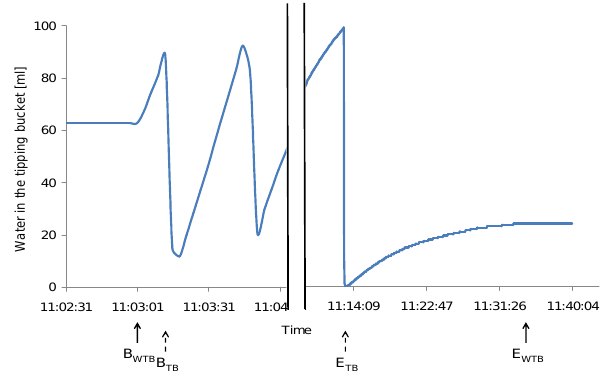
Fig. 4. Run-off event from concrete pavers at the 3rd of September 2009 in Berlin-Marienfelde. The dynamics were studied using the traditional tipping bucket (TB) signals compared to the weighable tipping bucket (WTB) data. B TB , B WTB and E TB E WTB indicate the beginning and the end of the run-off event as detected by the tipping bucket and the weighable tipping bucket, respectively. Note, that the time axis is interrupted and scaled